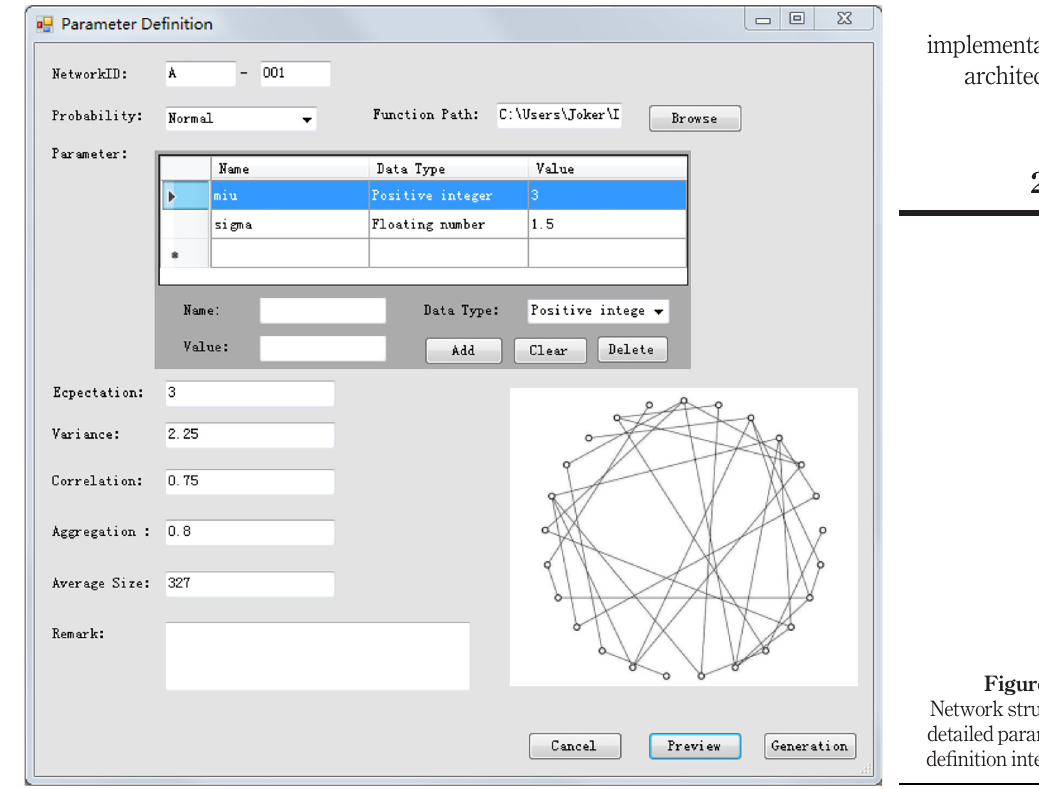
Figure 11. Network